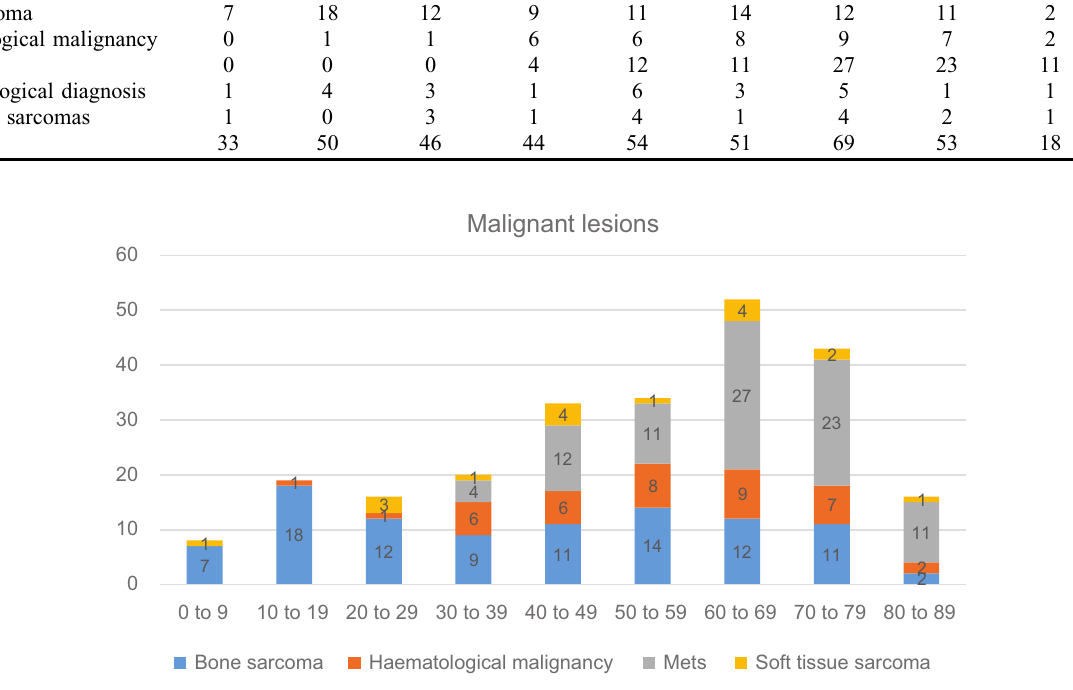
Figure 1. The subtypes of malignant lesions of the